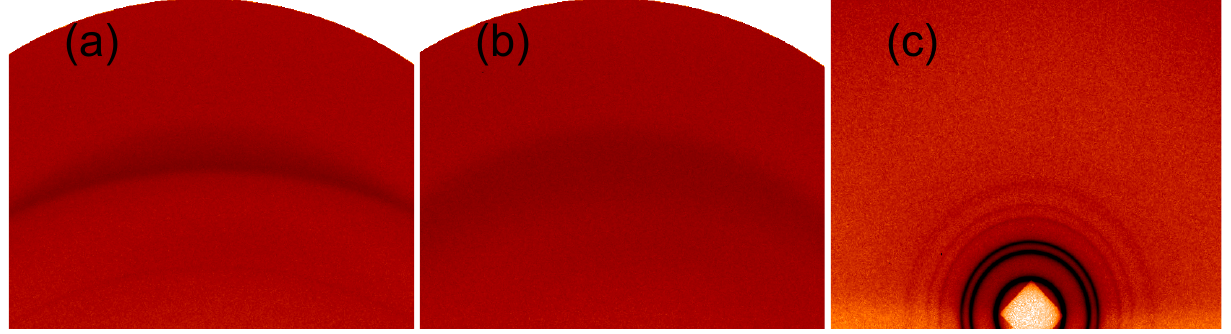
2. Small angle X-ray scattering (SAXS) patterns for DOPC (1,2-dioleoyl- sn -glycero-3-phosphocholine): ( a ) gel phase at − 33 °C; ( b ) fluid phase at 2.6 °C; and ( c ) inverse hexagonal phase at 36 °C. In comparison with the fluid phase ( b ), the gel phase ( a ) has an extra reflection and stronger reflections. The inverse hexagonal phase ( c ) has more reflections at small angles. (a) (b)